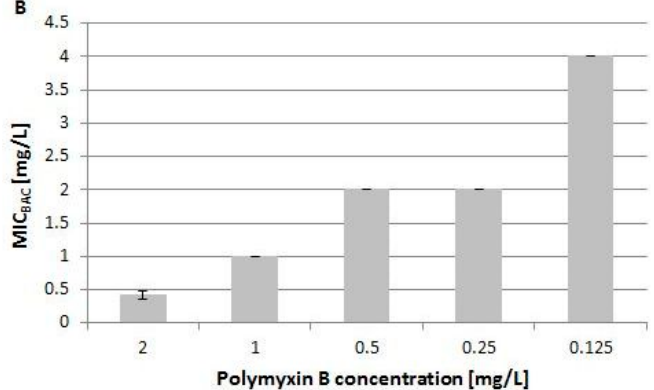
Figure 2. Minimum inhibitory concentrations of BAC (benzalkonium chloride) depending on the Polymyxin B concentration in the medium. ( A ) MIC values of BAC for E. coli CFT073, ( B ) MIC values of BAC for E. coli 2009-70-65-10. Data presented here are from three biological replicates. Bars represent standard errors.